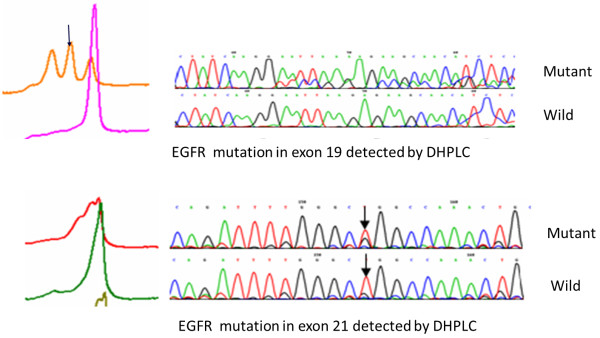
EGFR mutation detected by DHPLC.